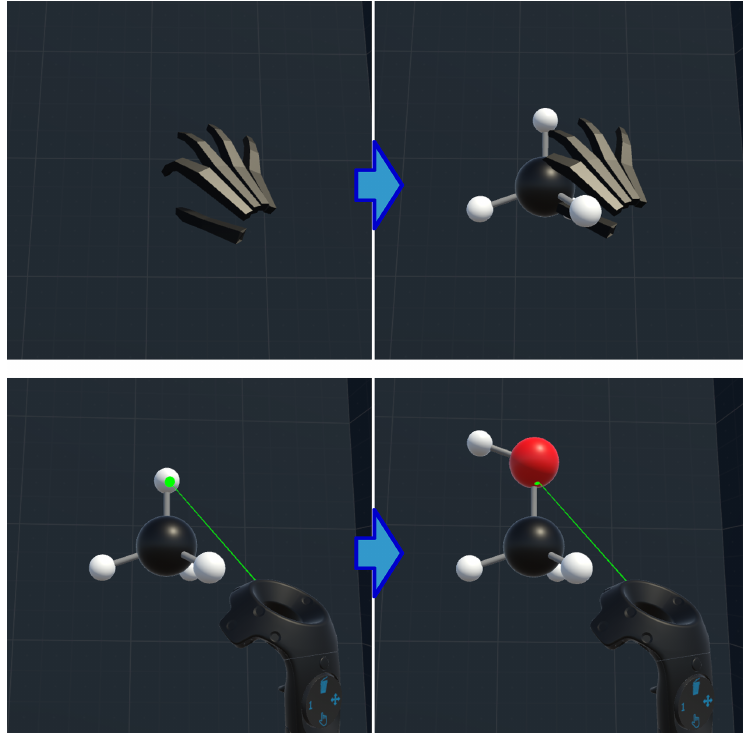
Figure 6. Atoms and bonds are created with a right hand pinch gesture ( above ) or a controller trigger press ( below ). Touching existing atoms or molecules with the pinch or pointing at them with the controller replaces or modifies